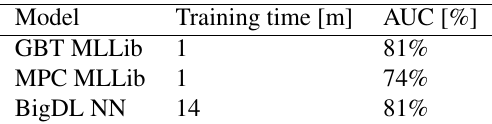
Figure 2. [a]: Strong scaling e ffi ciency measured on a single machine, obtained by measuring the training time of two MLLib ML models (GBT, blue circles, and MPC, red triangles) as a function of the number of cores. The number of Spark executors is set to one. [b]: Strong scaling e ffi ciency measured on a homogeneous cluster, obtained by measuring the training time of two ML models from MLLib (MPC, blue circles) and BigDL (NN, red triangles) as a function of the number of cores. The number of cores per Spark executor is set to five for the MLLib model, and to one for the BigDL model. Table 1. Training time in minutes and AUC in percentage for the three ML models used in the scaling